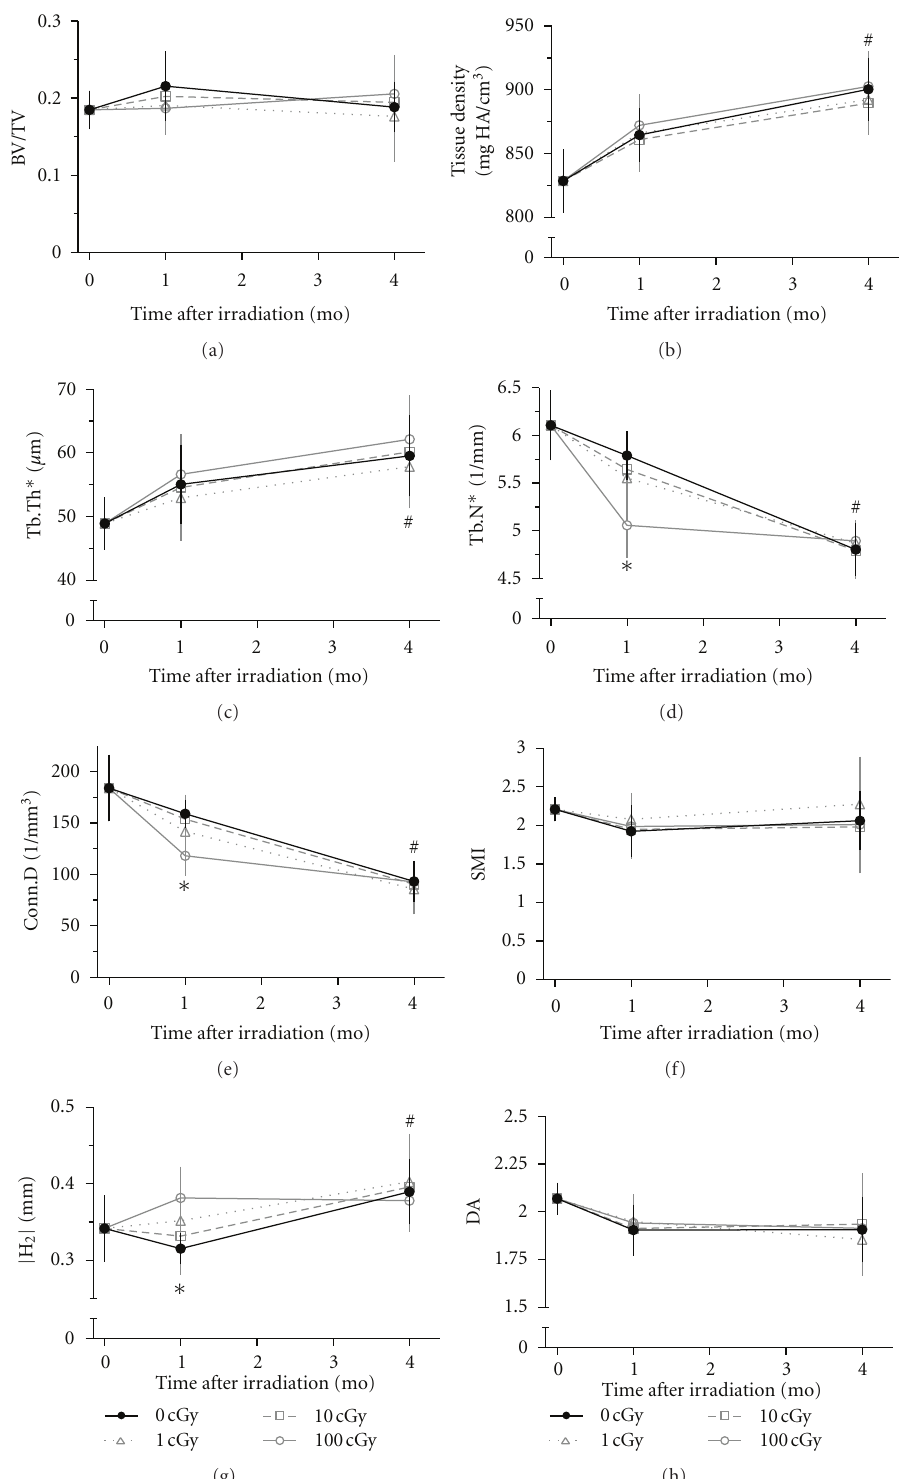
Figure 2: Cancellous microarchitecture of the proximal tibial metaphysis as a function of age and radiation exposure at the time of irradiation (basal, 0 months) and 1 and 4 months after irradiation. During aging, sham-irradiated controls show relative bone volume (BV/TV) remaining constant (a), increases in tissue density (b) and trabecular thickness (Tb.Th ∗ ) (c), and declines in trabecular number (Tb.N ∗ ) (d) and connectivity density (Conn.D) (e). The ratio of trabecular rods to plates, the structure model index (SMI), remains constant with age (f). The maximum eigenvalue ( | H 2 | ) of the fabric tensor increases with age (g), with the degree of anisotropy (h) remaining constant. At 1 month after irradiation, 100cGy reduced Tb.N ∗ by 20% (d), Conn.D by 36% (e) compared to age-matched controls. Irradiation at 100 cGy, but not at 1 cGy or 10 cGy, altered cancellous structure within 1 month in a direction and magnitude similar to 4 months of normal aging, with no further modulation between 1 and 4 months after irradiation. Mean ± SD. ∗ Denotes P < 0 . 05 for changes with IR dose (ANOVA and Tukey-Kramer posthoc compared to age-matched sham controls). # Denotes P < 0 . 05 for changes with age (linear